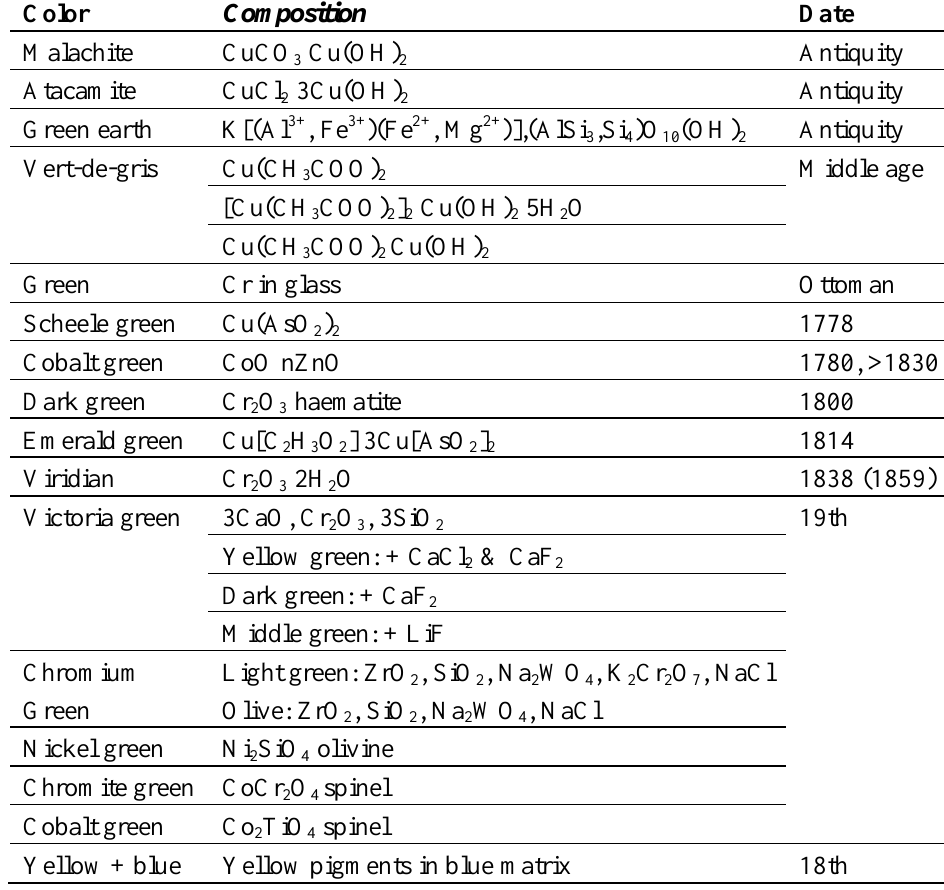
Table 4. Name and composition of green pigments and coloring agents. Dates of innovation (first production) are